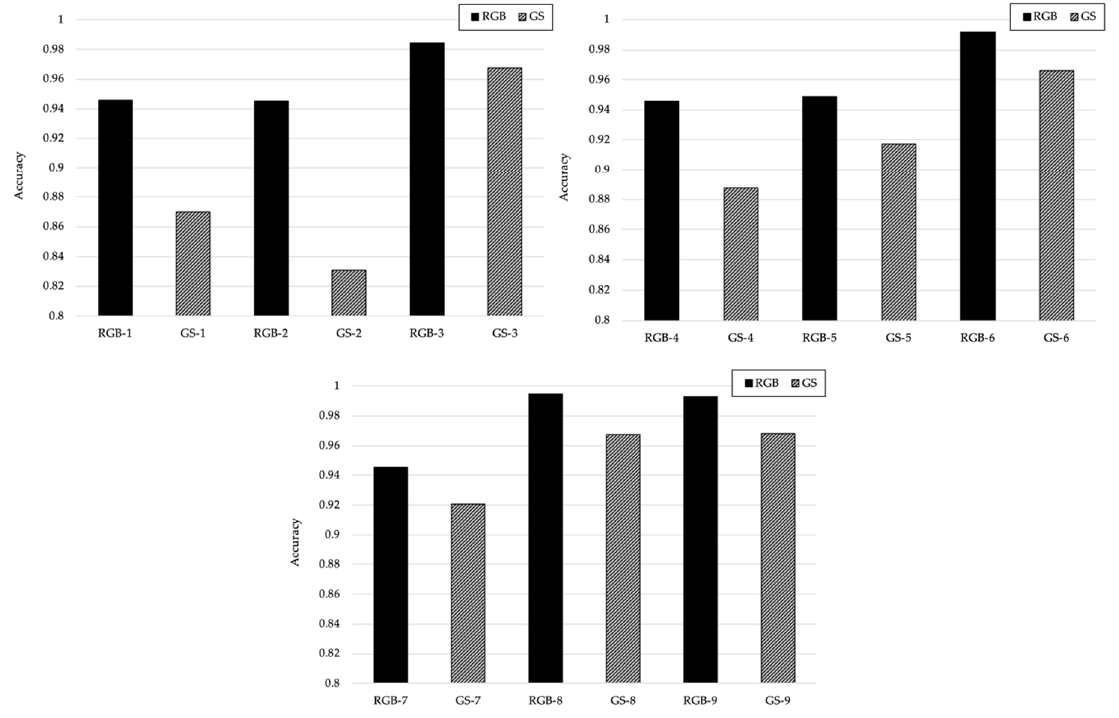
Figure 7. Accuracy Comparison of RGB and grayscale in multiclass classification of CSE-CIC-IDS 2018.